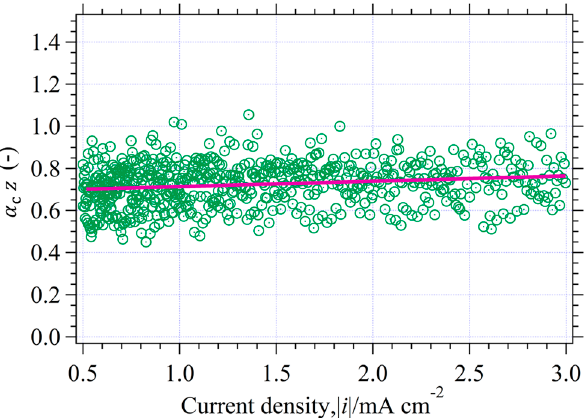
Figure 9. The relation between α c z and | i | is plotted using Equation (30). The value of α c z was ≈ 0.7 by the least ‐ squares approximation method.